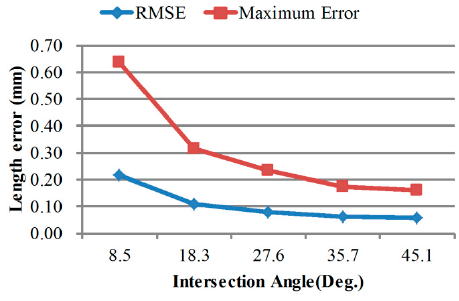
Figure 12. Bar length measurement error varies with intersection angle.